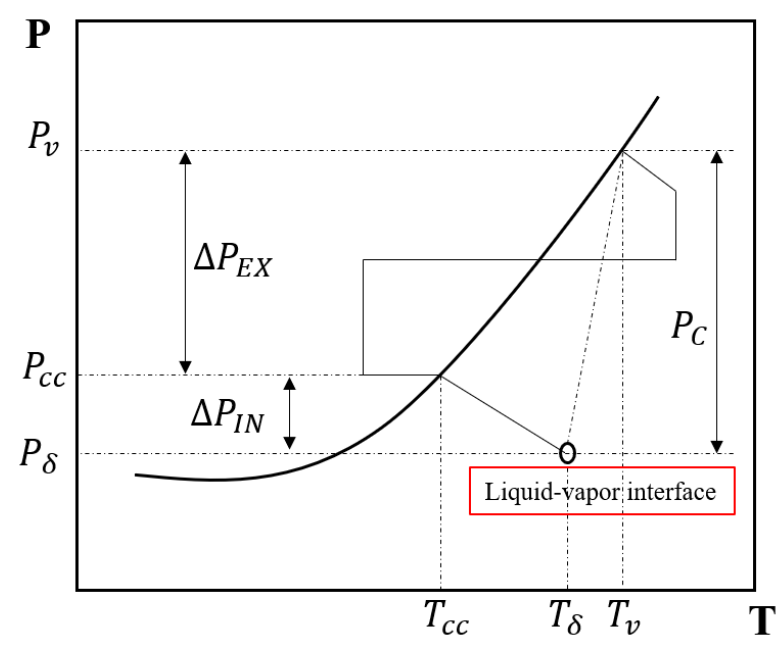
Figure 6. Diagram of the LHP working cycle .